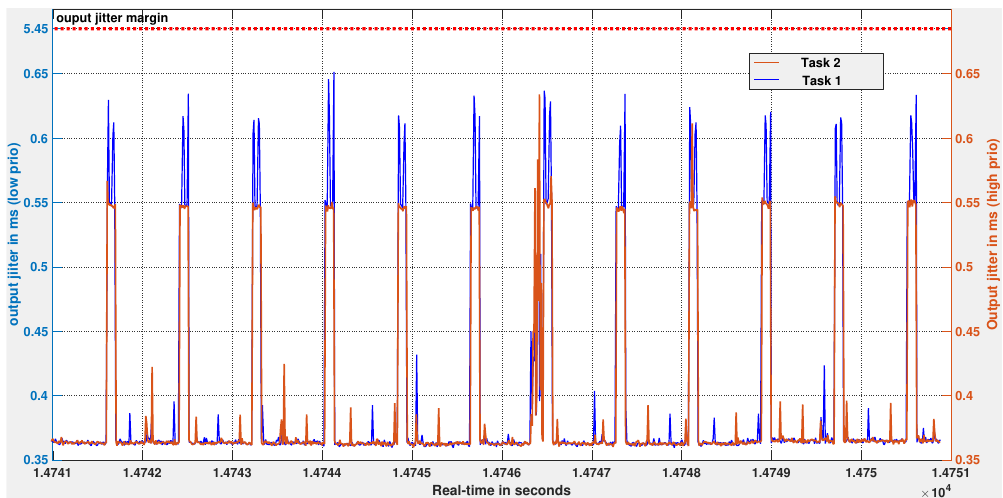
Figure 12. Global view of output jitter measurements of Task 1 and Task 2. The output jitter J τ of Task 1 (blue curve, left y-axis) varies over time but remains below 0.65 ms. The output jitter of Task 2 (red curve, right y-axis) is bounded by 0.63 ms. The design assumption of output jitters for Task 1 is less than 5.45 ms is met by the